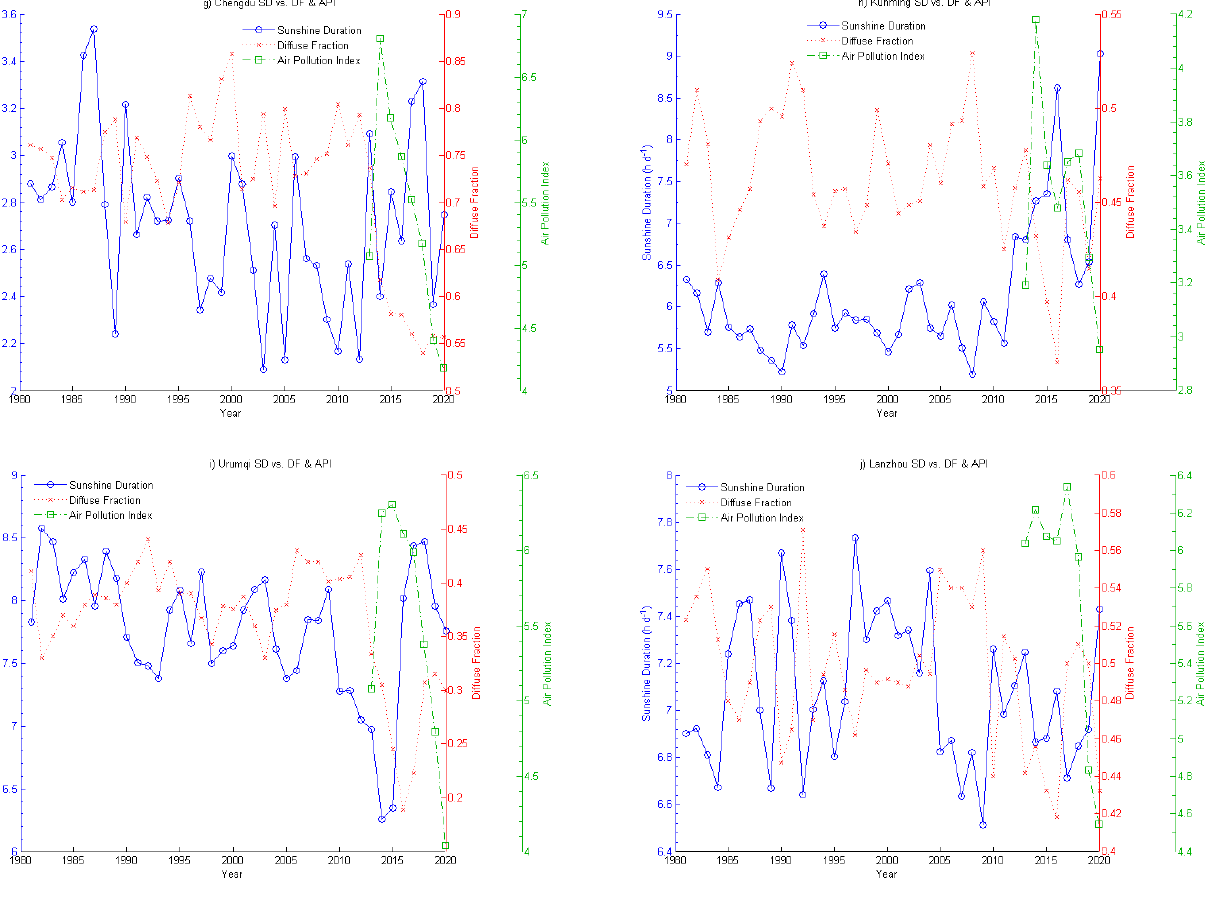
Figure 7. Interannual changes in averaged SD, DF and API for the ten cities from 1981 to 2020. ( a ) For Beijing; ( b ) For Shenyang; ( c ) For Harbin; ( d ) For Shanghai; ( e ) For Wuhan; ( f ) For Guangzhou; ( g ) For Chengdu; ( h ) For Kunming; ( i ) For Urumqi; ( j ) For Lanzhou.